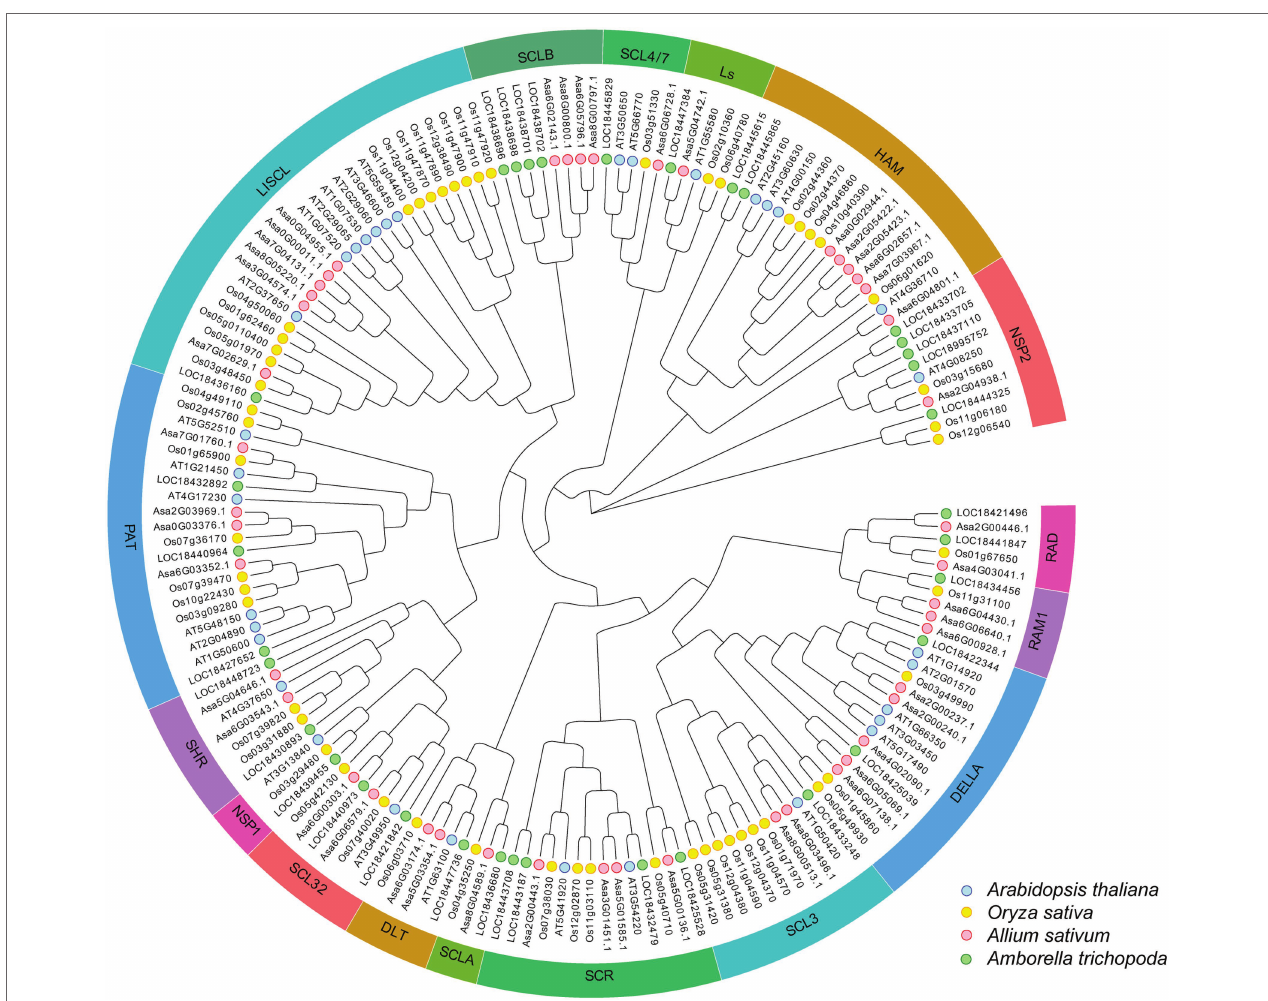
FIGURE 2 | Unrooted phylogenetic tree representing relationships among GRAS families of four plant species. The phylogenetic tree was constructed using the NJ method and shows 17 subfamilies. GRAS proteins from Allium sativum L., Arabidopsis , Oryza sativa, and Amborella trichopoda are marked with red, blue, yellow, and green,